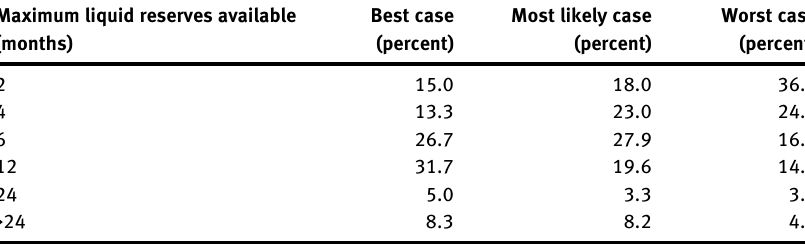
Table  : Estimated development of liquidity in best, most likely, and worst case (n =  ). Maximum liquid reserves